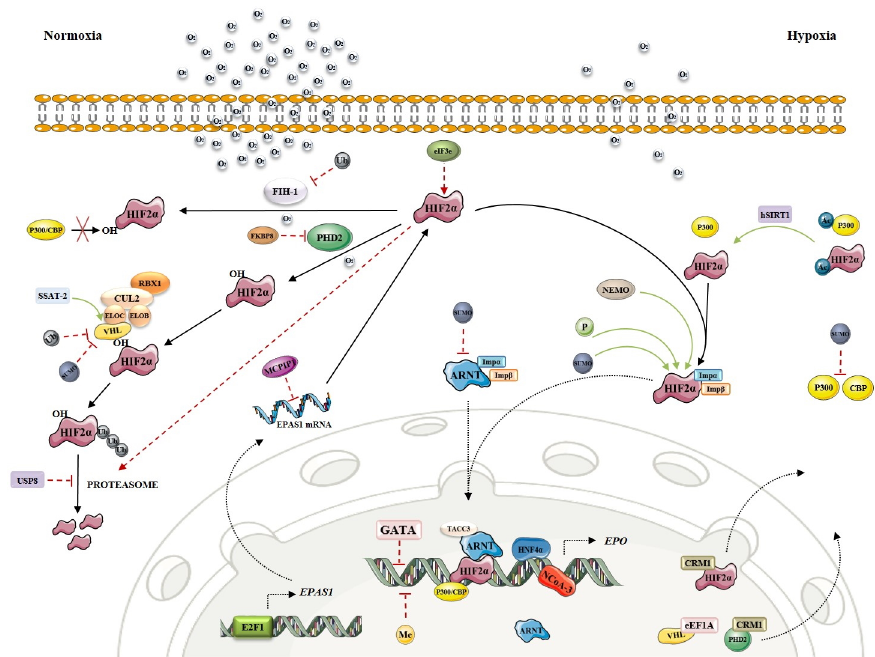
Figure 1. Molecular mechanisms of HIF-EPO pathway. The red line indicates an inhibitory effect. Green line indicates the activation/stabilization effect. Black line indicates transition. Circles